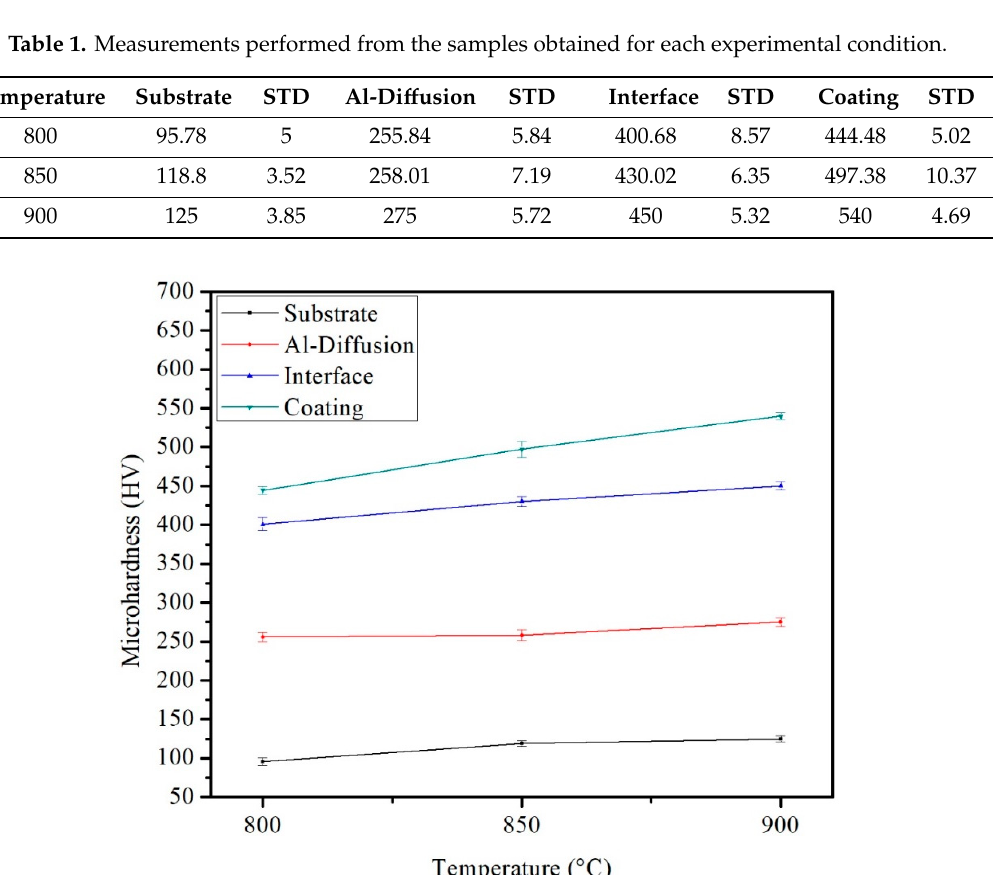
Figure 10. Microhardness values of the sample layers as a function of processing temperature including scattering bars (constant processing pressure of 20 MPa and time of 7200 s).